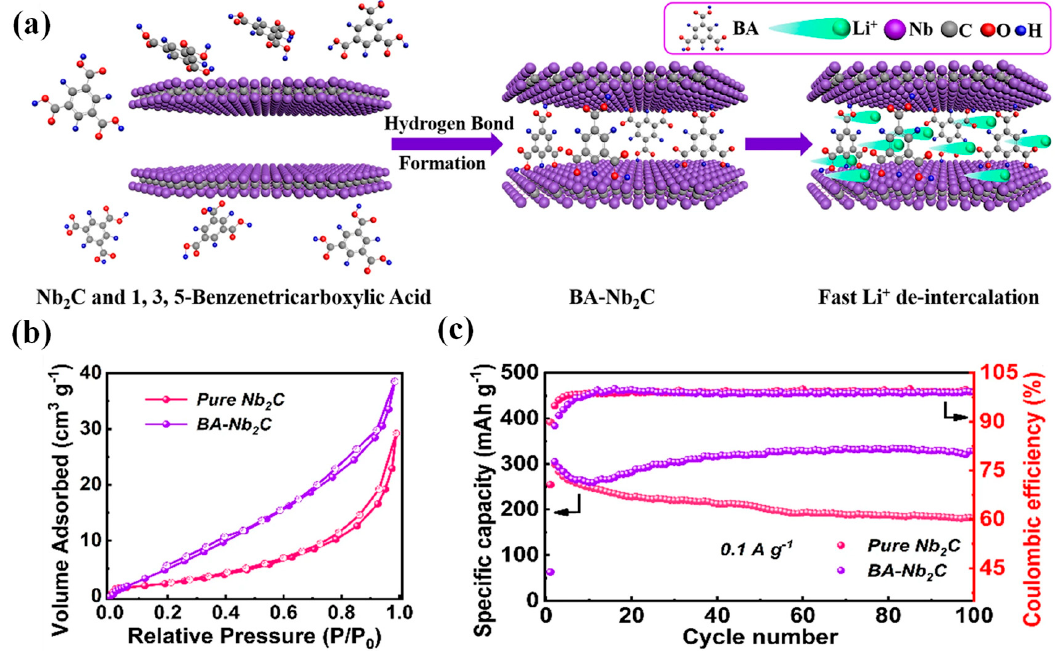
Figure 5. BA-Nb 2 C as anode materials for LIBs. ( a ) Schematic illustration of the synthesis mecha- nism, ( b ) Nitrogen adsorption–desorption isotherms of pure Nb 2 C and BA-Nb 2 C, ( c ) cycling stability of BA-Nb 2 C at 0.1 A/g. Copyright Springer Nature, 2022